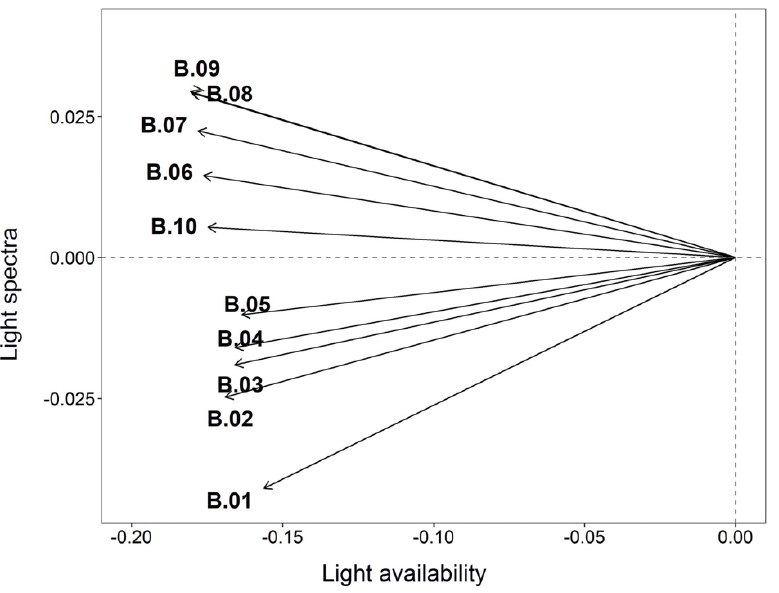
Figure 4. K d variables Intrastructure graph. The light availability axis is related to K d , with low light (high K d ) on the left and high values (low K d ) on the right. The light spectrum axis is related to the different wavelengths (400 nm to 700 nm).The greater length of the arrows related to wavelength bands 6–10 compared to those related to bands 1–5 indicates that species using green-red wavelengths in the 600–700 nm range have a competitive advantage to being establish in these environments.